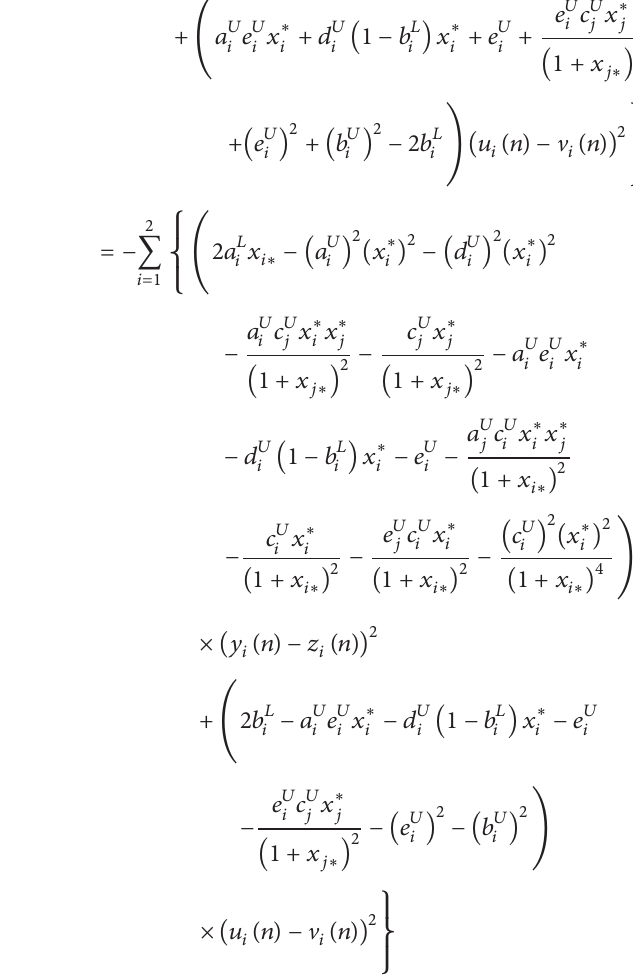
(0) = 0.034, 𝑢 (0) = 0.012 for 𝑛 ∈ [0, 100] , 1 2